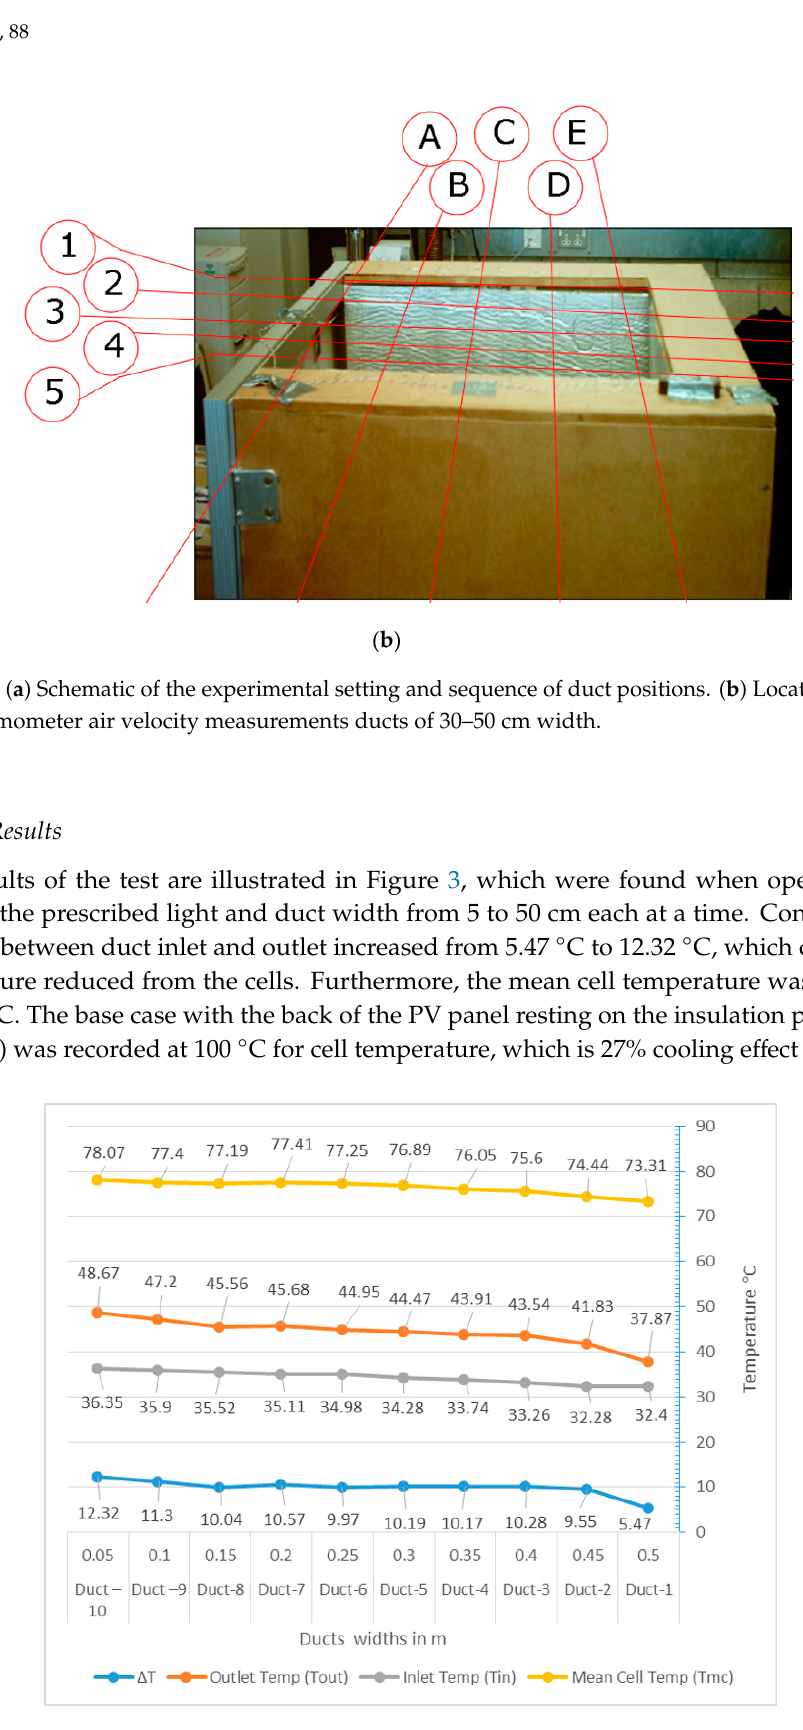
Figure 3. Experimental results.